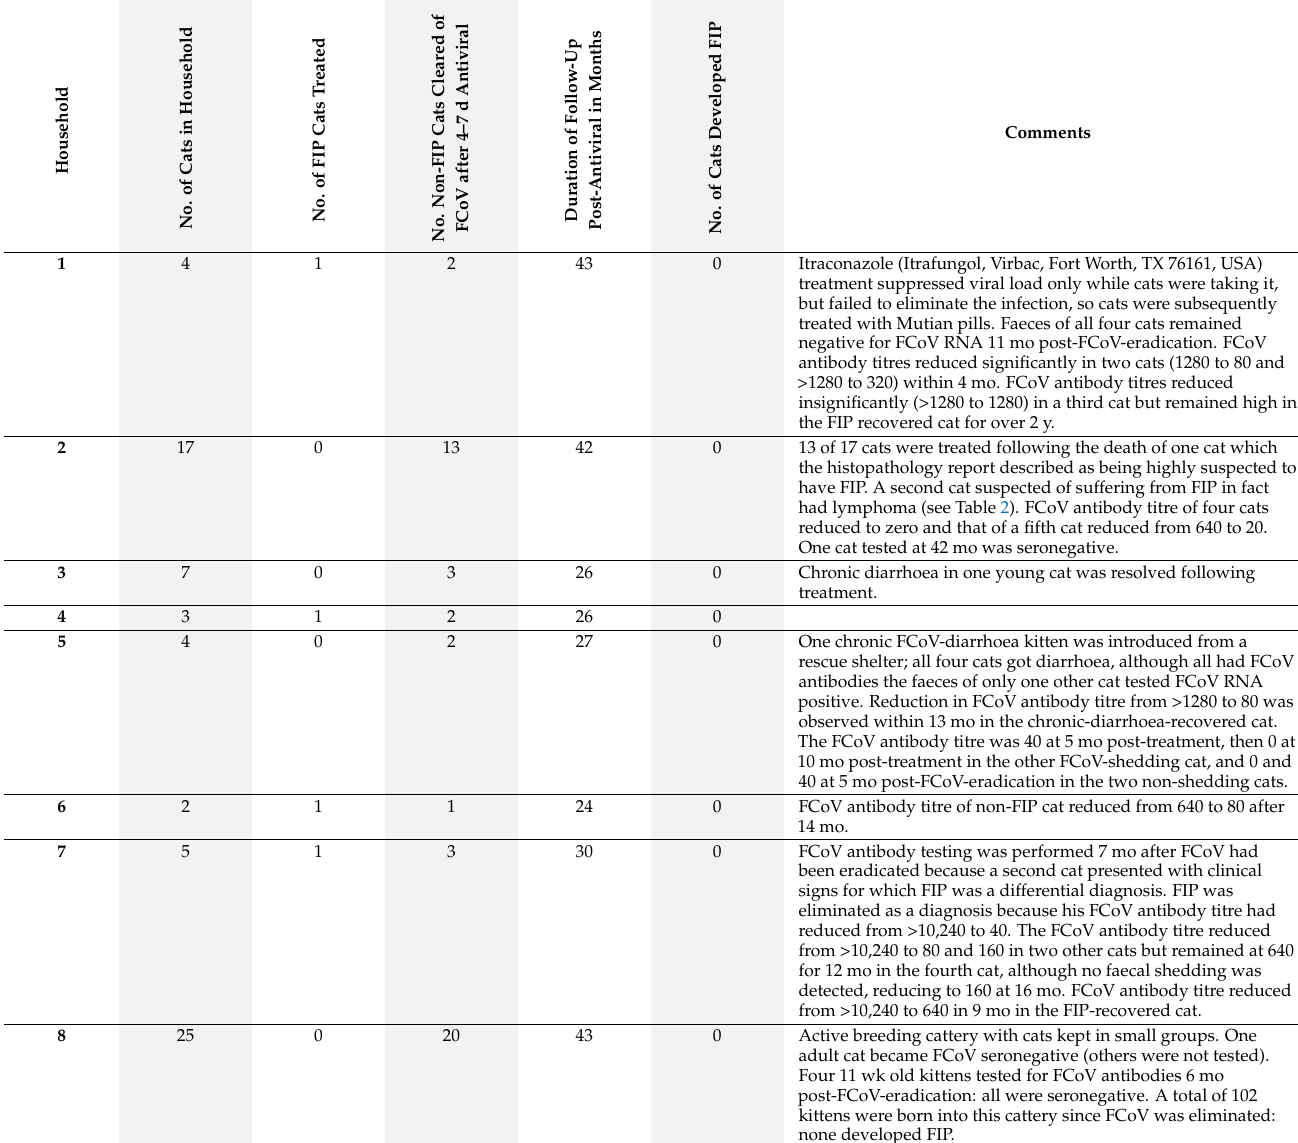
Table 1. Description of 147 cats in 27 households from which FCoV was